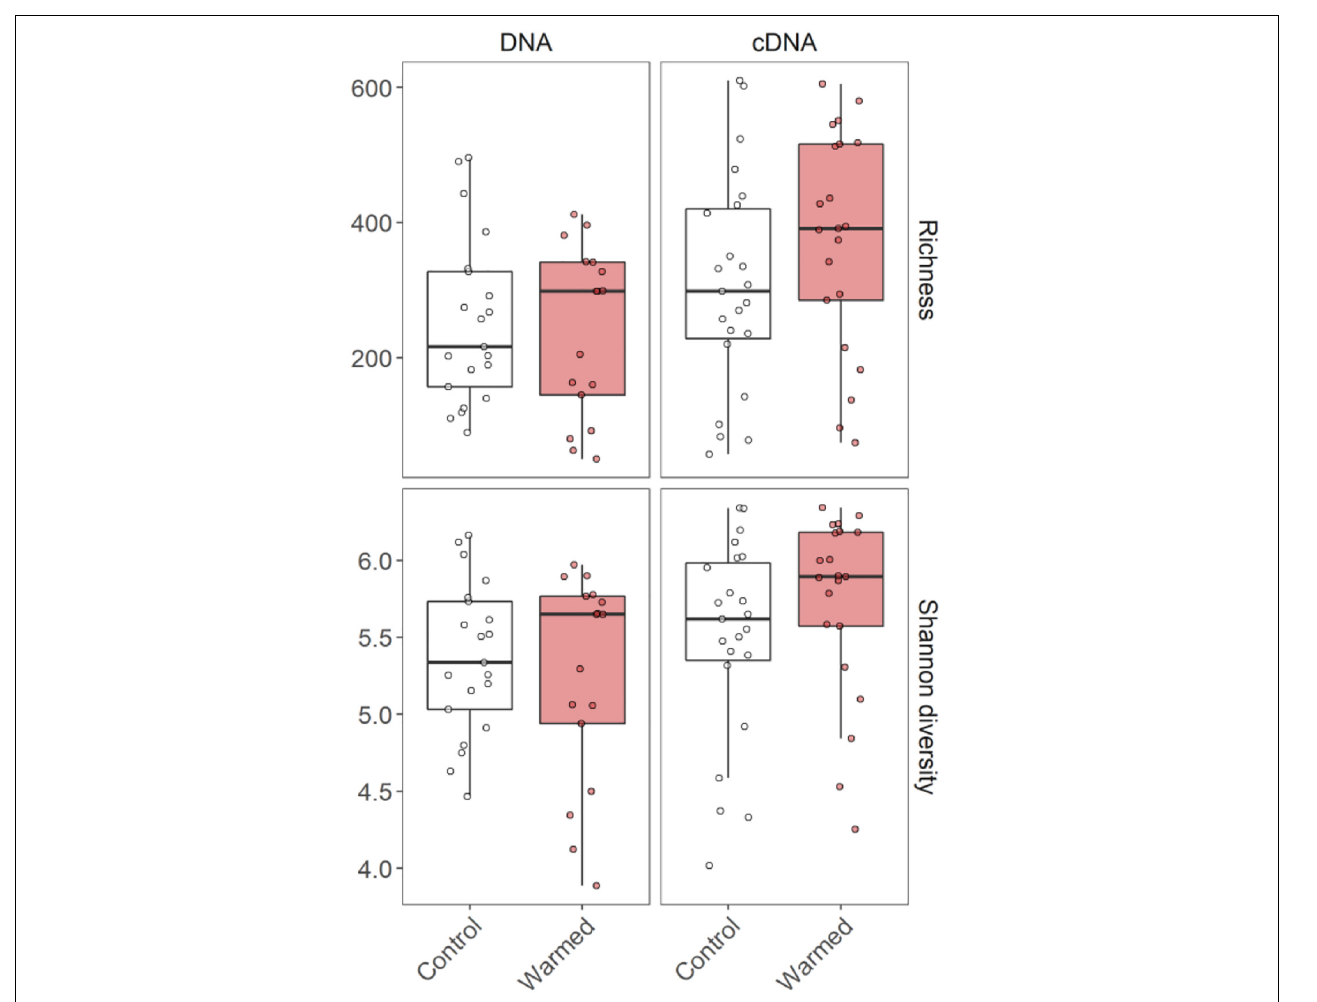
FIGURE 1 | ASV richness and Shannon diversity of the DNA and cDNA-based bacterial communities associated with the lichen C. islandica in control and warmed samples. N = 82, n = 21 for DNA control, n = 17 for DNA warmed, n = 23 for cDNA control and n = 21 for cDNA